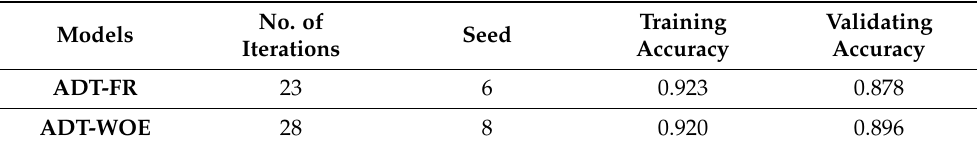
Table 4. The optimal parameters of the ADT based ensembles.